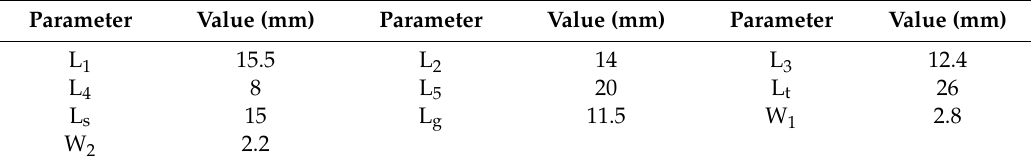
Figure 1. Development of the single-element MIMO antenna ( a ) Reference antenna A; ( b ) reference antenna B; ( c ) reference antenna C; ( d ) the proposed antenna element. Table 1. The dimensional values of the antenna element.